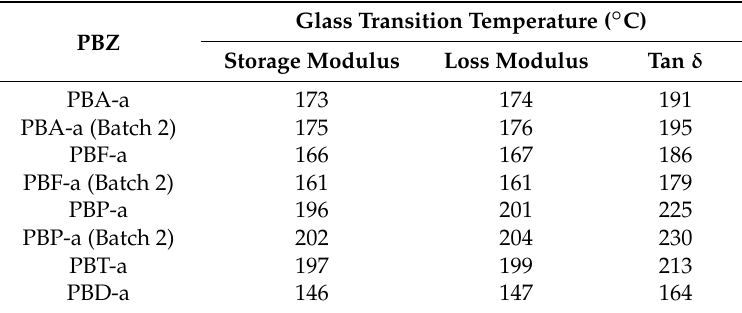
Table 5. Crosslink density calculated from DMTA data.